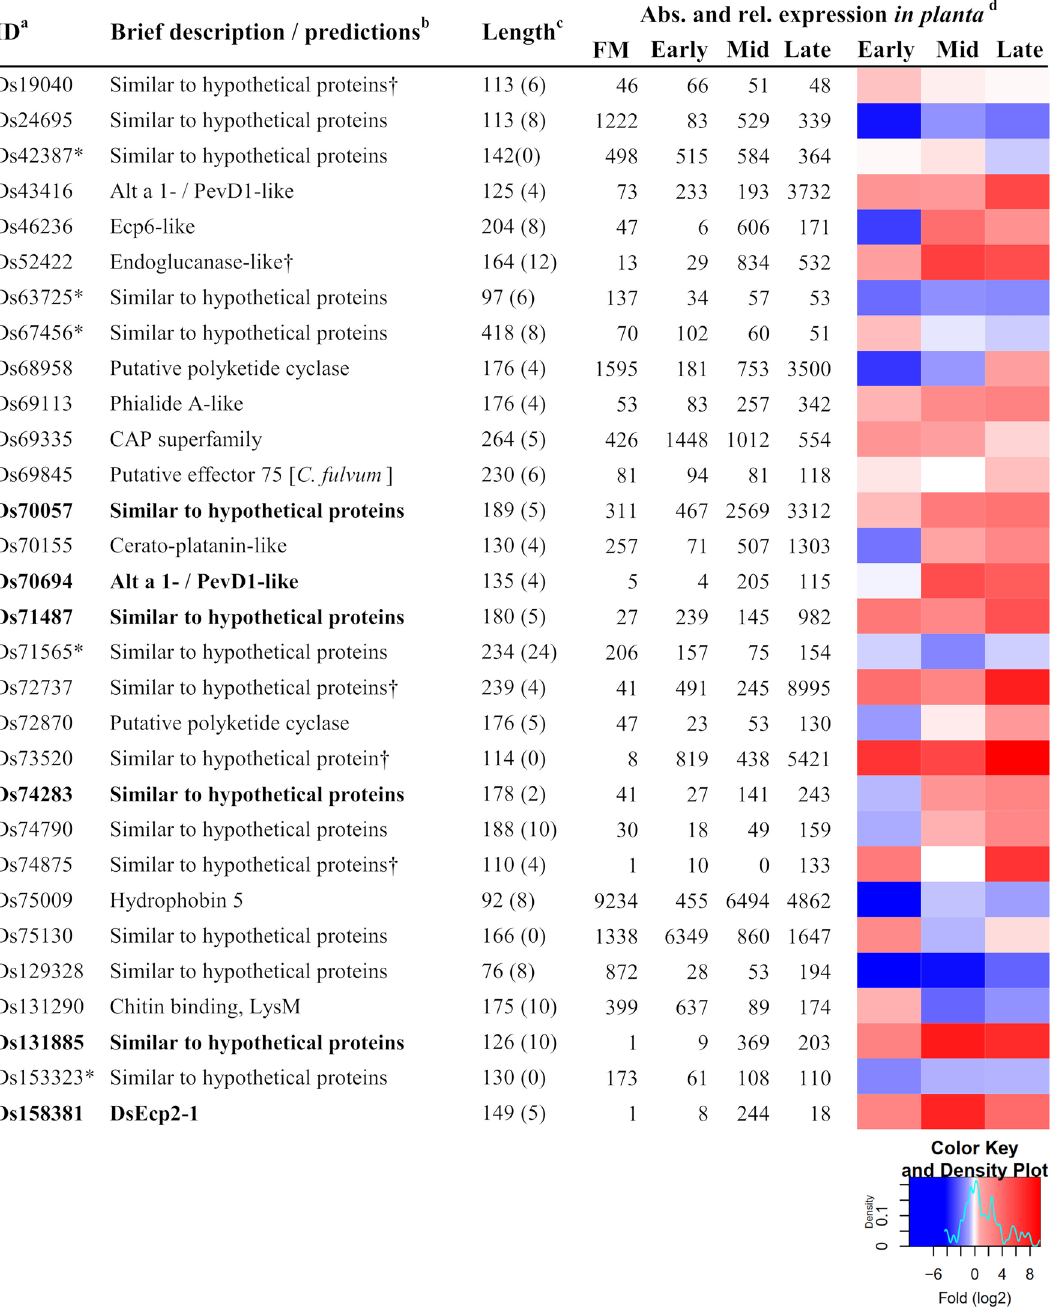
Figure 1. Cloned Dothistroma septosporum candidate effectors. Description and expression of the 30 shortlisted D. septosporum effector candidates used in this study. a Protein ID numbers refer to those at JGI (https:// mycoc osm. jgi. doe. gov/ Dotse1/ Dotse1. home. html). An asterisk indicates a non-apoplastic localisation prediction according to EffectorP3.0. b Function predictions were based on BLASTp (E < 1e−05) and HHpred. A dagger indicates that no sequence homologues were found in other foliar pine pathogens for which predicted proteomes were available. c Mature protein length (predicted N-terminal signal peptide removed) in amino acids; number of cysteine residues shown in brackets. d D. septosporum gene expression in culture (FM; fungal mycelium) and in planta ( Pinus radiata ) at Early, Mid, Late infection stages 27 . Left, Reads Per Million per Kilobase (RPMK); right, heatmap representing fold (log 2 ) changes relative to FM